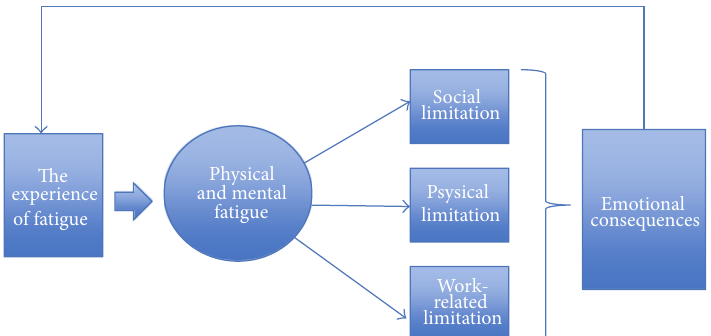
Figure 2: Experience of fatigue in IBD. The experience of fatigue begins with physical and mental symptoms, which leads to social-, physical-, and work-related limitations. These limitations may cause some emotional consequences like bad conscience. The emotional consequences are a part of the experience of